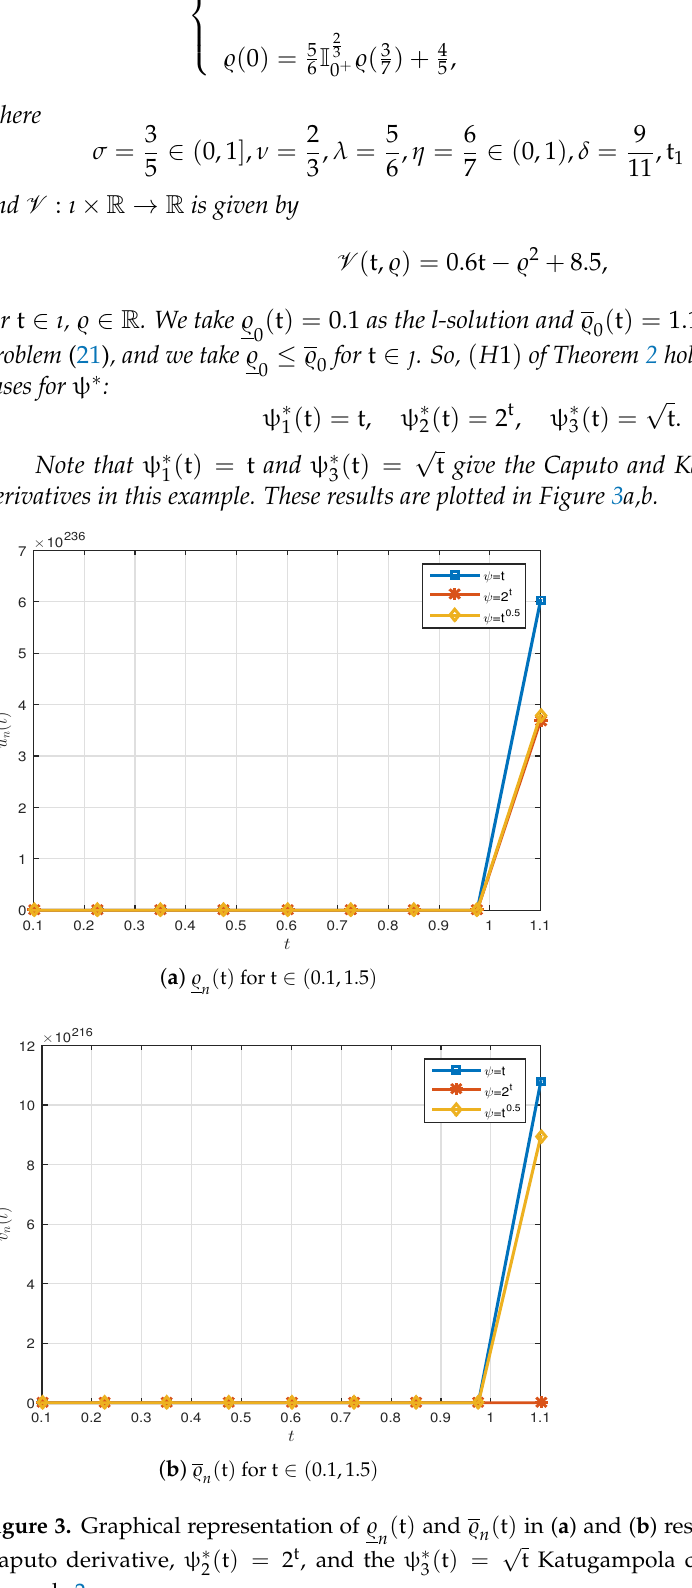
( t ) = 2 t , and the ψ ∗ 2